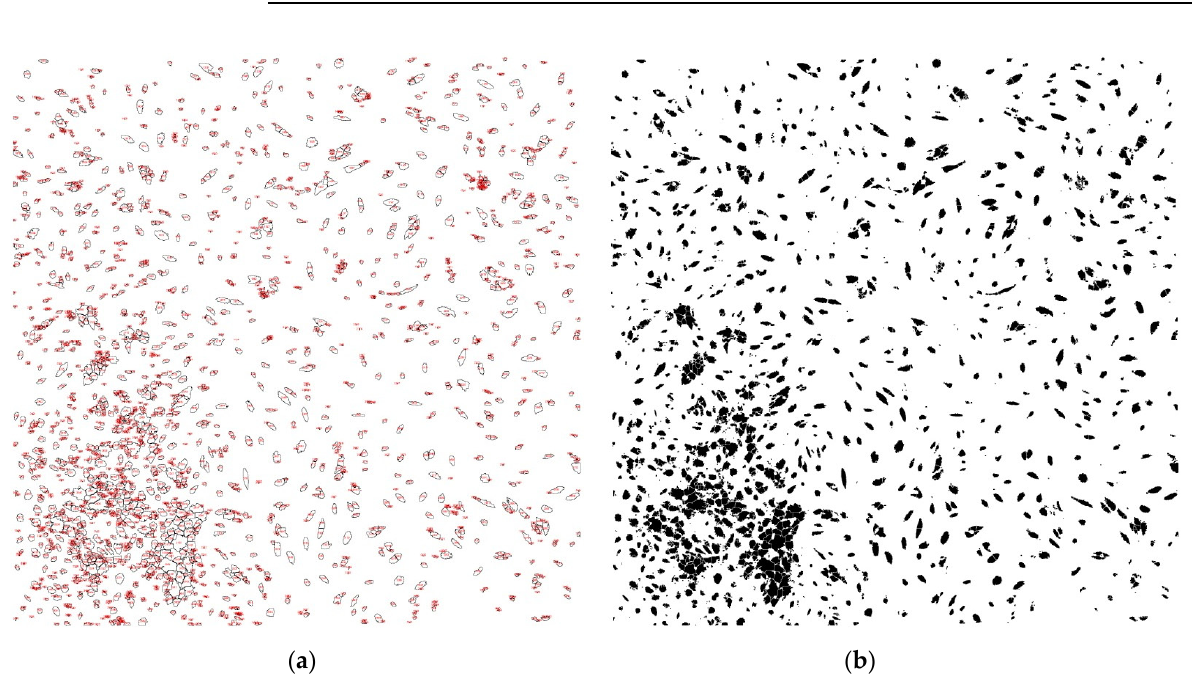
( a ) ( b ) Figure 4. Quantification of cell proliferation: (laser “-”) ( a ) cell counting ( b ) binary. 4. Discussion For this study we chose adult patients whose therapeutic indication would be extraction and that would require post-extraction regularization of the alveolar bone ridge or removal of a fractured bone fragment. In this way, the harvesting of bone tissue was done for the benefit of the patient, favoring post-extraction healing. In order to have a healthy bone fragment available, we excluded patients who had active periodontal disease or who had systemic conditions or medication that could impact the periodontal tissues.